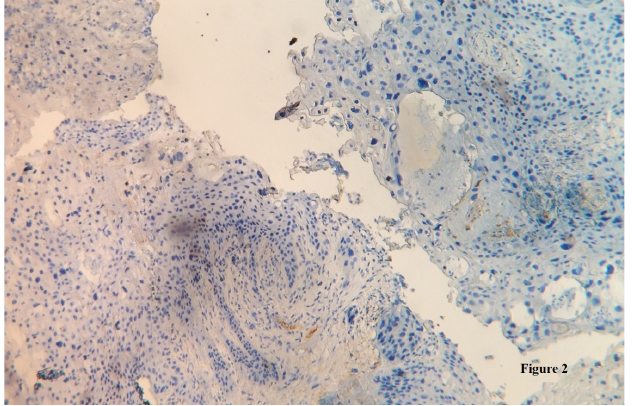
Fig.2. Immunohistochemical expression of TIMP-2 / OSCC negative control.